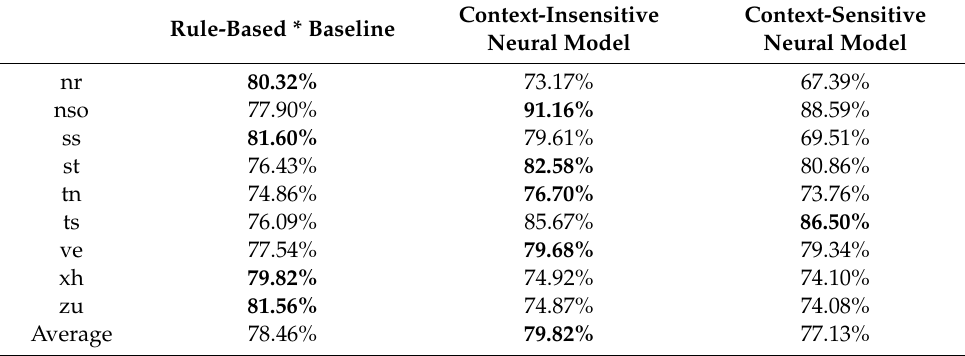
Table 10. Lemmatisation F1 scores on 9 SA languages; numerically highest scores per language are in bold